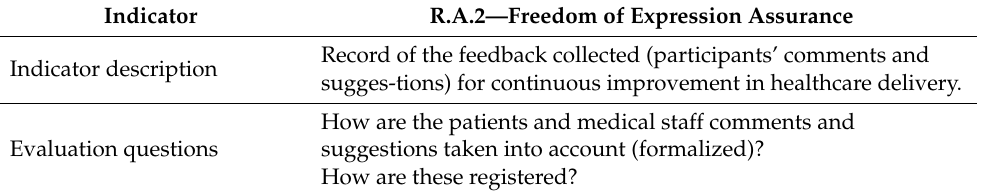
Table 17. R.A.2—Freedom of expression assurance.